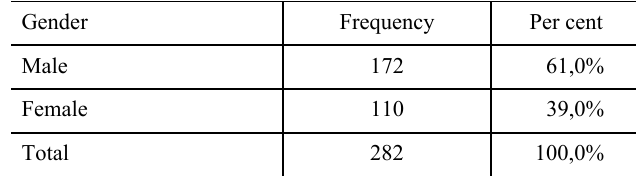
Table 2: Gender of the respondents